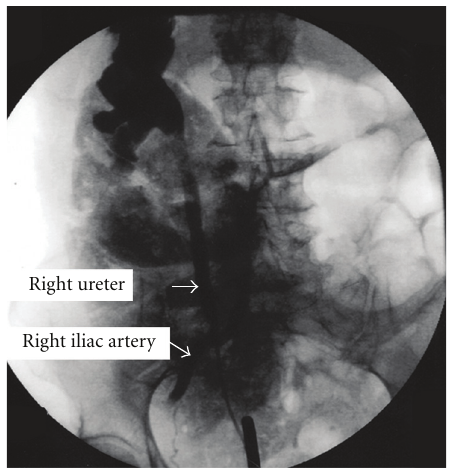
Figure 2: Retrograde pyelogram showing fistula between right iliac artery and right ureter. Note the cystoscope tip and ureteral catheter extending up the distal ureter.